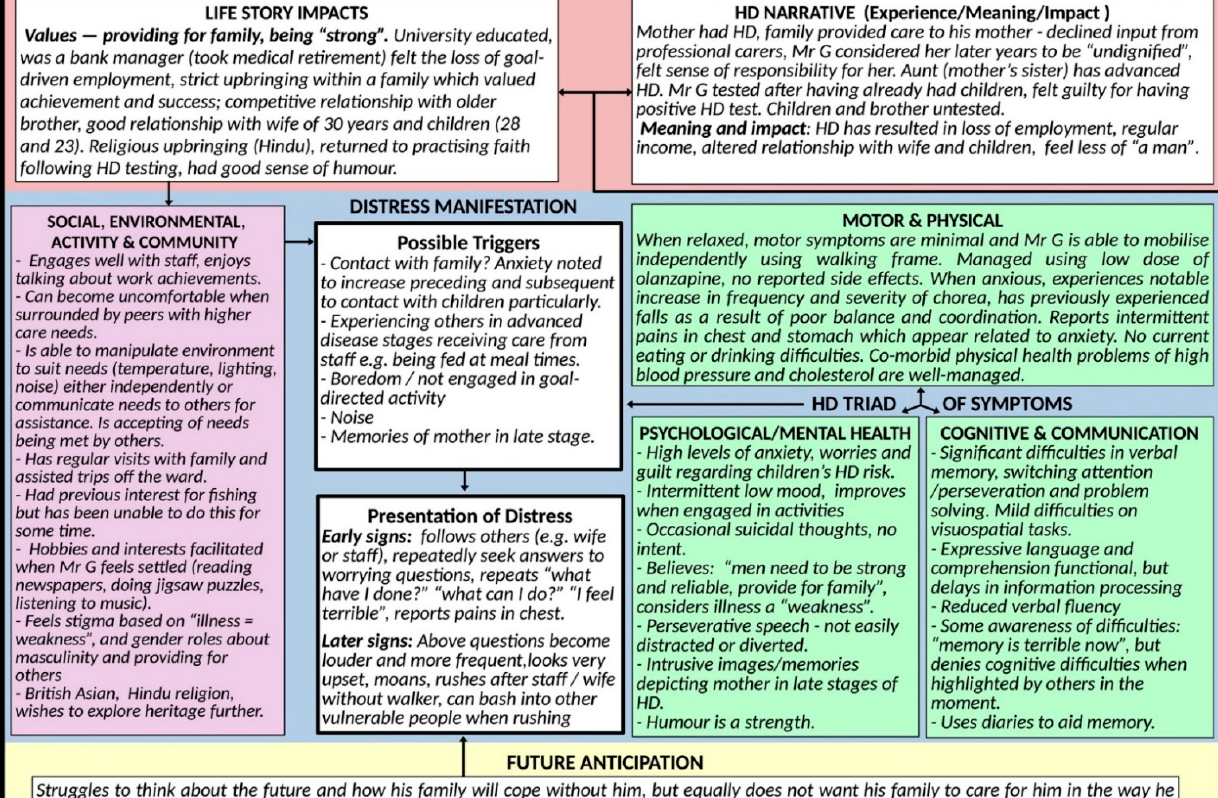
Figure 2. Case example of Mr G.